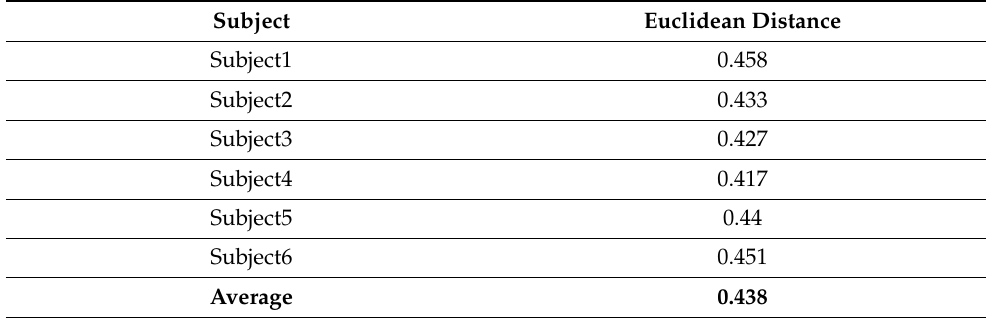
Table 1. Euclidean distances from six